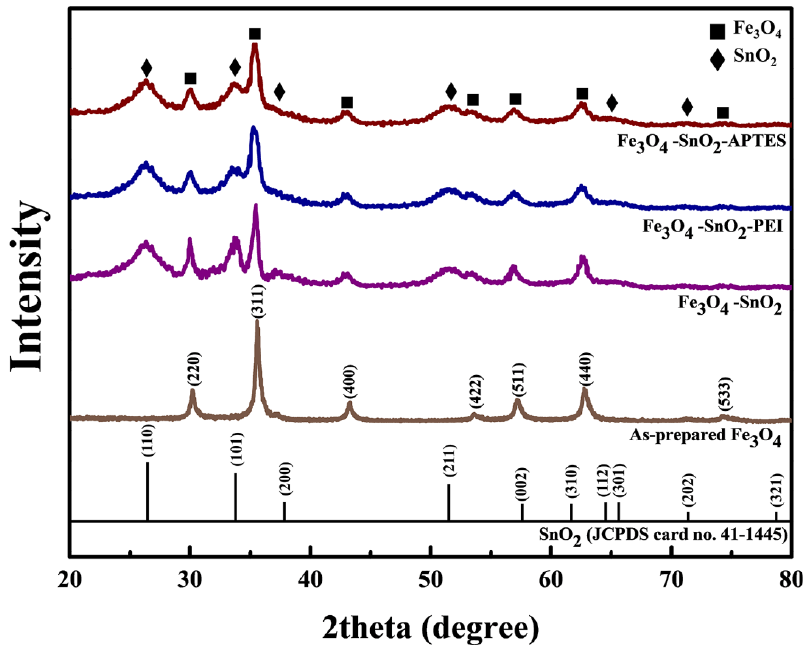
Figure 4. XRD patterns of the as-prepared Fe 3 O 4 , Fe 3 O 4 -SnO 2 , PEI-treated Fe 3 O 4 -SnO 2 , and APTES- treated Fe 3 O 4 -SnO 2 nanoparticles.